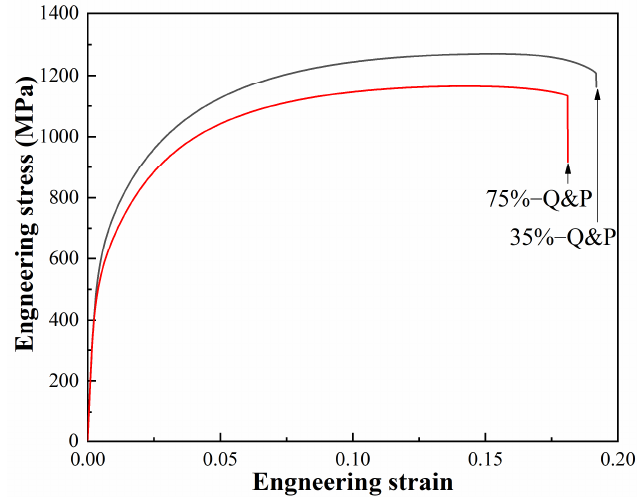
Figure 7. The engineering stress-strain plots of 35%—Q&P sample and 75%—Q&P sample. Table 1. The yield strength (YS), tensile strength (TS), total elongation (EL), and product of strength and elongation (PSE) of 35%—Q&P sample and 75%—Q&P sample.